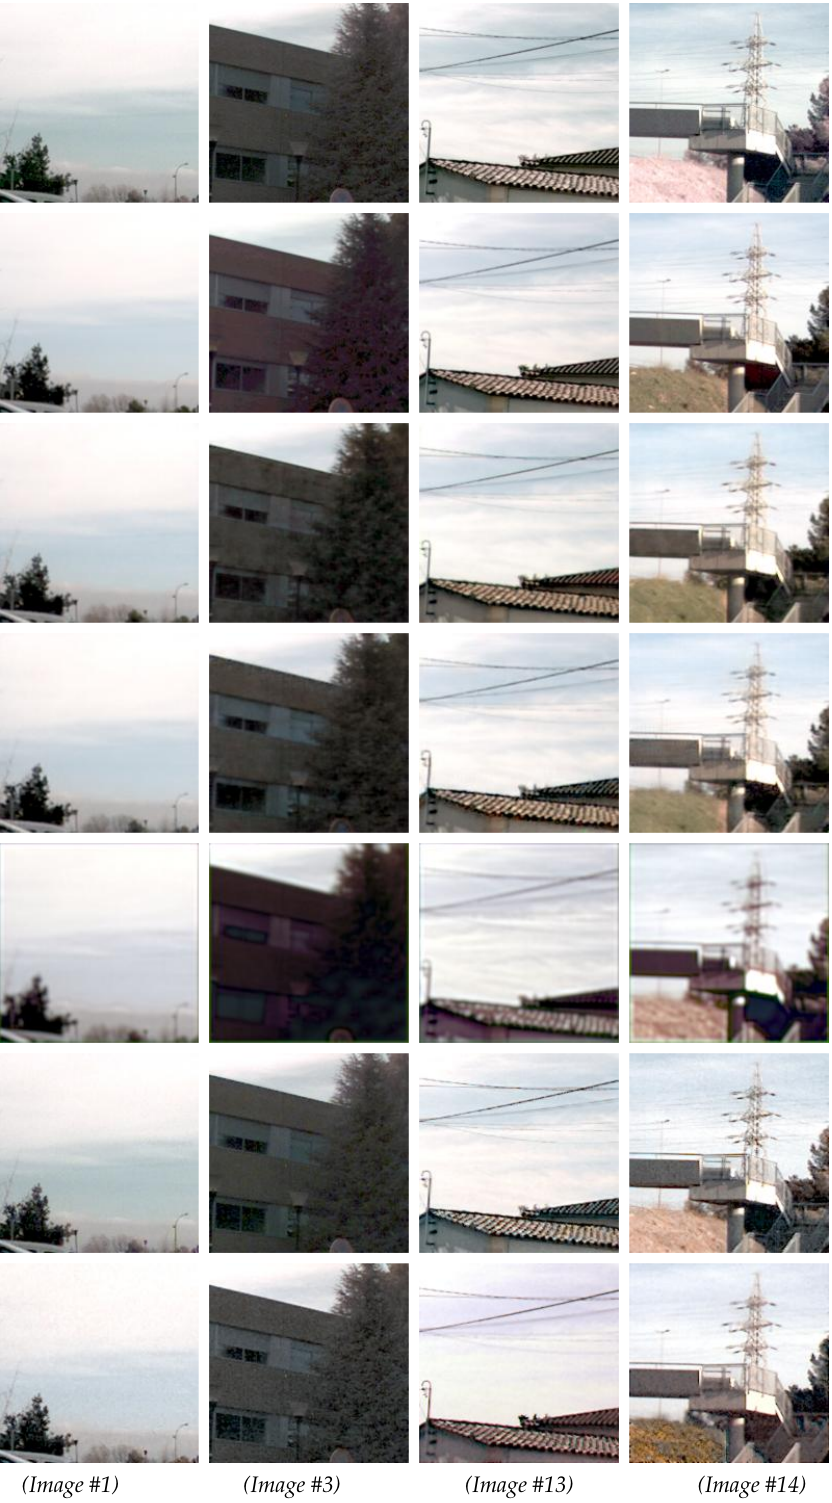
Figure 5. Four samples from the best results (see Table 2). ( 1st row ) X images (RGB+N). ( 2nd row ) Y (ground truth). ( 3rd row ) Results from CDNet. ( 4th row ) Results from ENDENet. ( 5th row ) Results obtained with the Super-Resolution Convolutional Neural Network (SRCNN) ([30]). ( 6th row ) Results obtained with ref. [21]. ( 7th row ) Results obtained with ref. [20]. The image numbers correspond to the values presented in Table